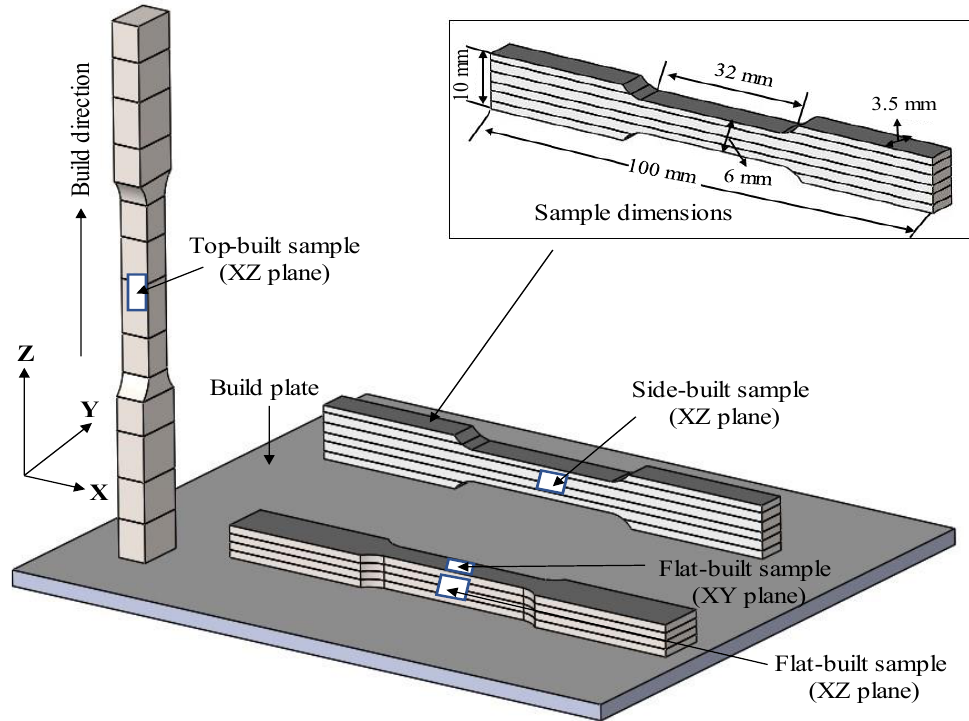
Figure 1. CAD design with dimensions (inserted image) of the sub-sized Ti6Al4V tensile specimens for the EBM process with samples organized in three orientations with respect to the build table. Test coupons extracted for microstructural evaluation are marked with white boxes.